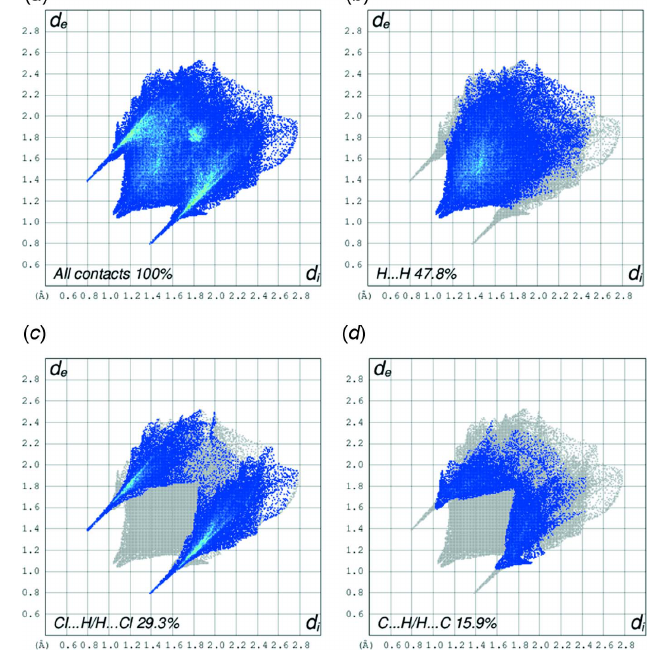
Figure 6 Two-dimensional fingerprint plots for the title compound, showing ( a ) all interactions, and decomposed into ( b ) H (cid:2)(cid:2)(cid:2) H, ( c ) Cl (cid:2)(cid:2)(cid:2) H/H (cid:2)(cid:2)(cid:2) Cl, ( d ) C (cid:2)(cid:2)(cid:2) H/H (cid:2)(cid:2)(cid:2) C interactions. Values for d i and d e represent the closest internal and external distances (in A˚ ) from given points on the Hirshfeld